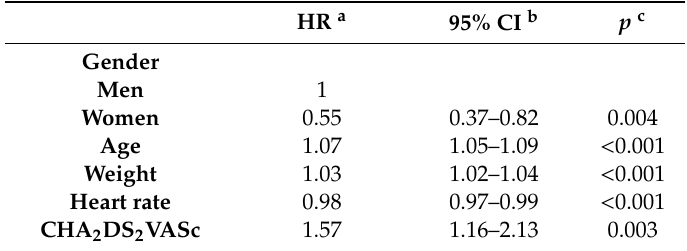
Table 3. Independent prognostic factors related to AF incidence at 5 years.